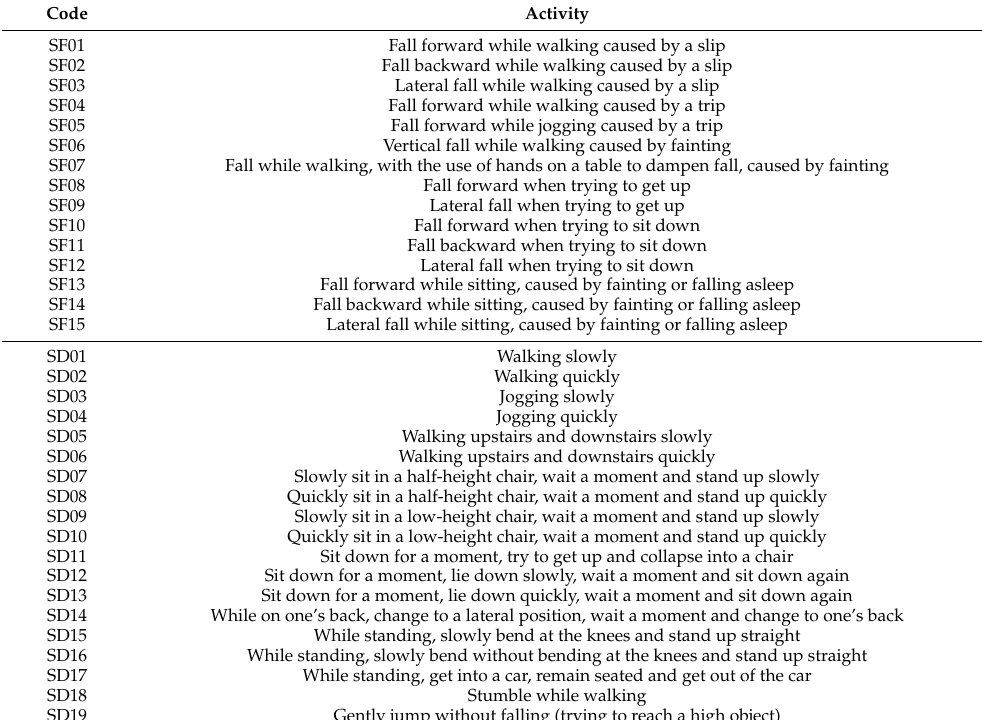
Table 2. Fall motions and ADLs in SisFall